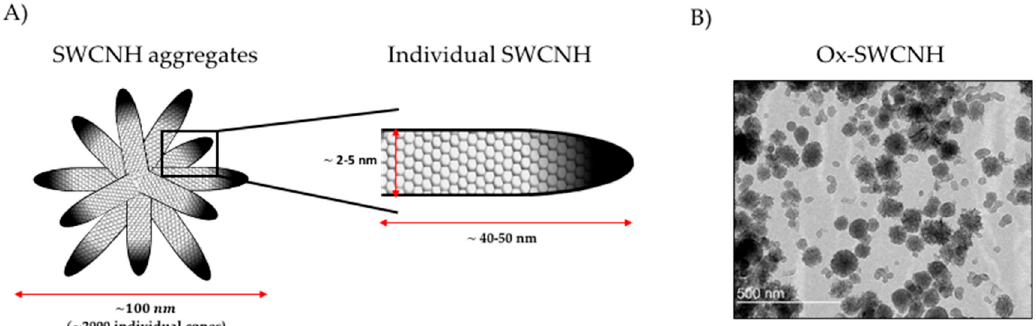
Figure 1. ( A ) schematic illustration of the structure of SWCNH; ( B ) representative image of carboxylated nanostructures obtained by Transmission Electron Microscopy (TEM). TEM image reprinted with permission from [21] (Melgar-Lesmes, P.; et al. Graphene-Dendrimer Nanostars for Targeted Macrophage Overexpression of Metalloproteinase 9 and Hepatic Fibrosis Precision Therapy. Nano Lett. 2018, 18, 5839–5845, doi:10.1021/acs.nanolett.8b02498), Copyright (2018) American Chemical Society.